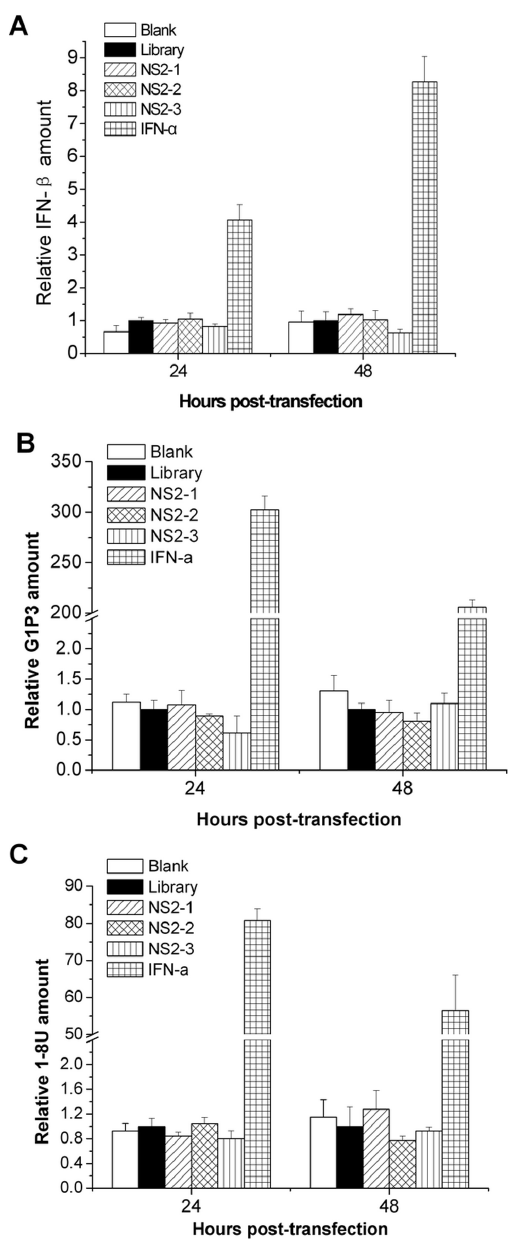
Figure 4. NS2-specific aptamers do not trigger innate immu- nity in HCV-infected Huh7.5 cells. HCV-infected Huh7.5 cells were treated by 100 nM aptamer or library for 24, 48 hours. Total cellular RNA was isolated. The level of IFN- b ( A ), G1P3 ( B ) and 18U ( C ) mRNA was quantified by real-time PCR and normalized with GAPDH respectively. IFN-a treatment was used as positive control. The data represented means of three different experiments. * P , 0.05, ** P , 0.01, *** P , 0.001 verse